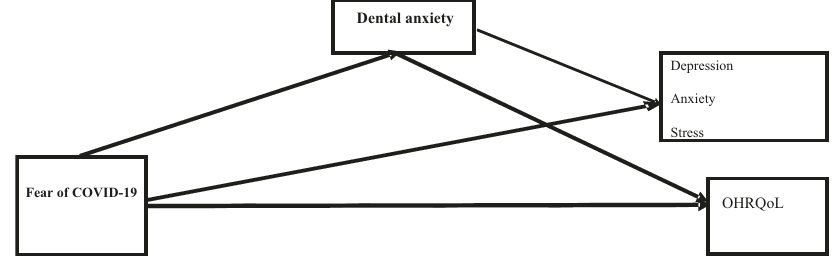
Fig. 1 The hypothesised model for the present study. Hypothesised model of the association of fear of COVID-19 and oral health related quality of life (QHRQoL) and psychological distress (including depression, anxiety, and stress) with mediating role of dental